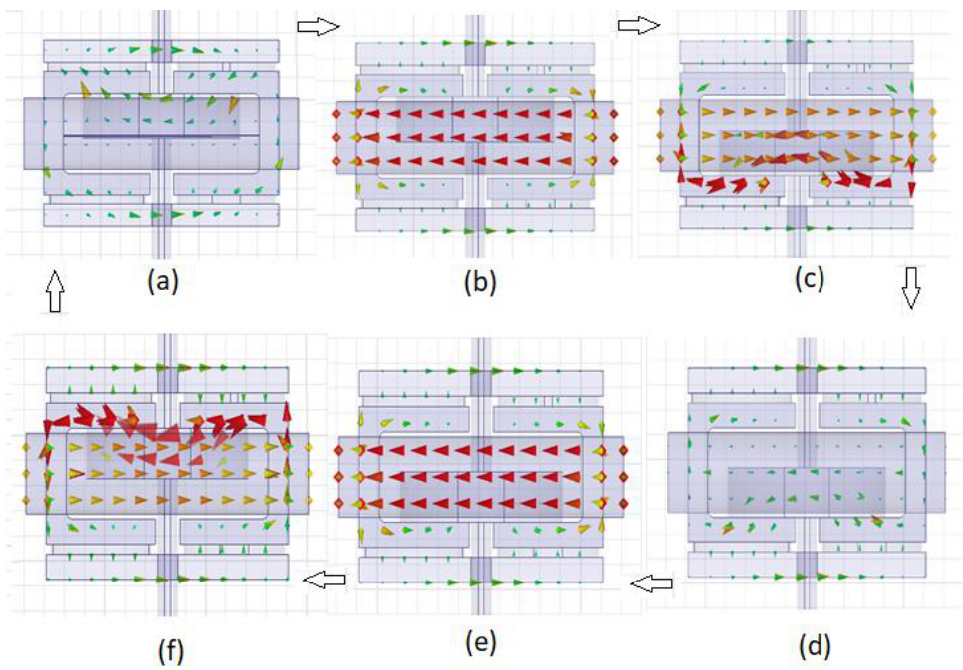
Figure 7. Magnetic flux flow: ( a ) when no current is passed; ( b ) during upper release pulse; ( c ) during catching pulse; ( d ) when no current is passed; ( e ) during lower release pulse; ( f ) when catching current is passed.